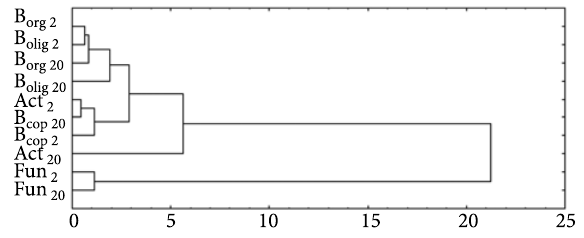
Fig. 1. Cluster analysis (CA) of clusters formed based on the abundance of soil microorganisms subjected to the impact of zinc (irrespectively of nitrogen fertilisation used)